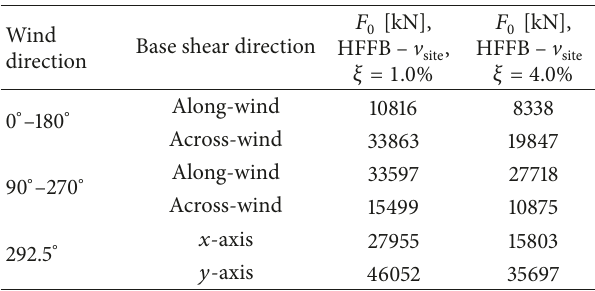
Table 12: Improvements by the